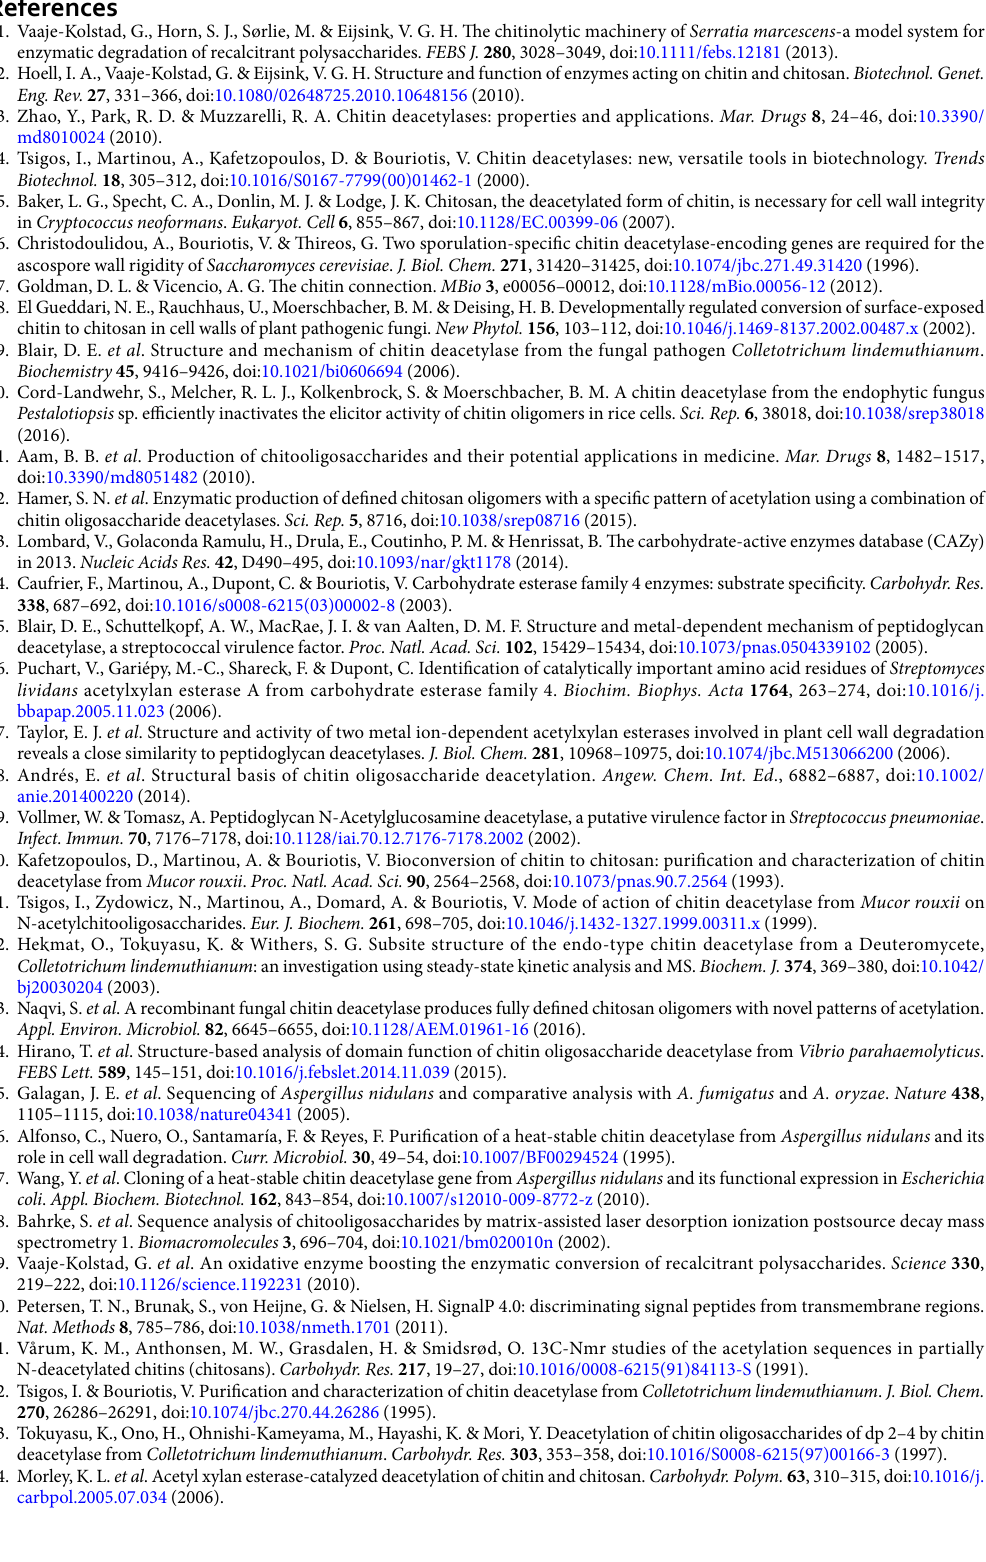
Table 2. The final model was validated with Procheck 50